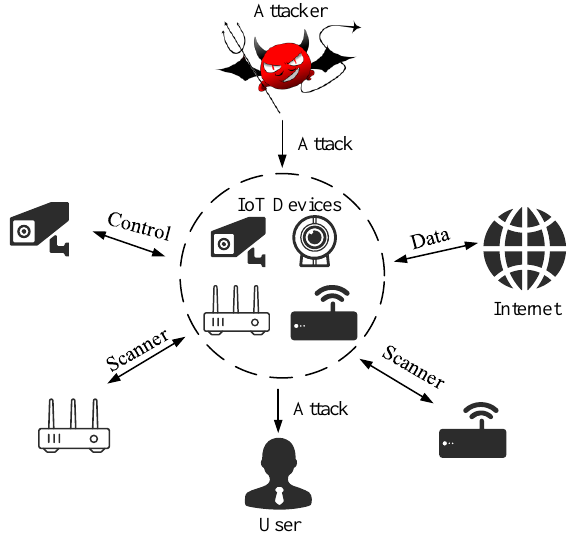
Figure 1. Internet of Things (IoT)